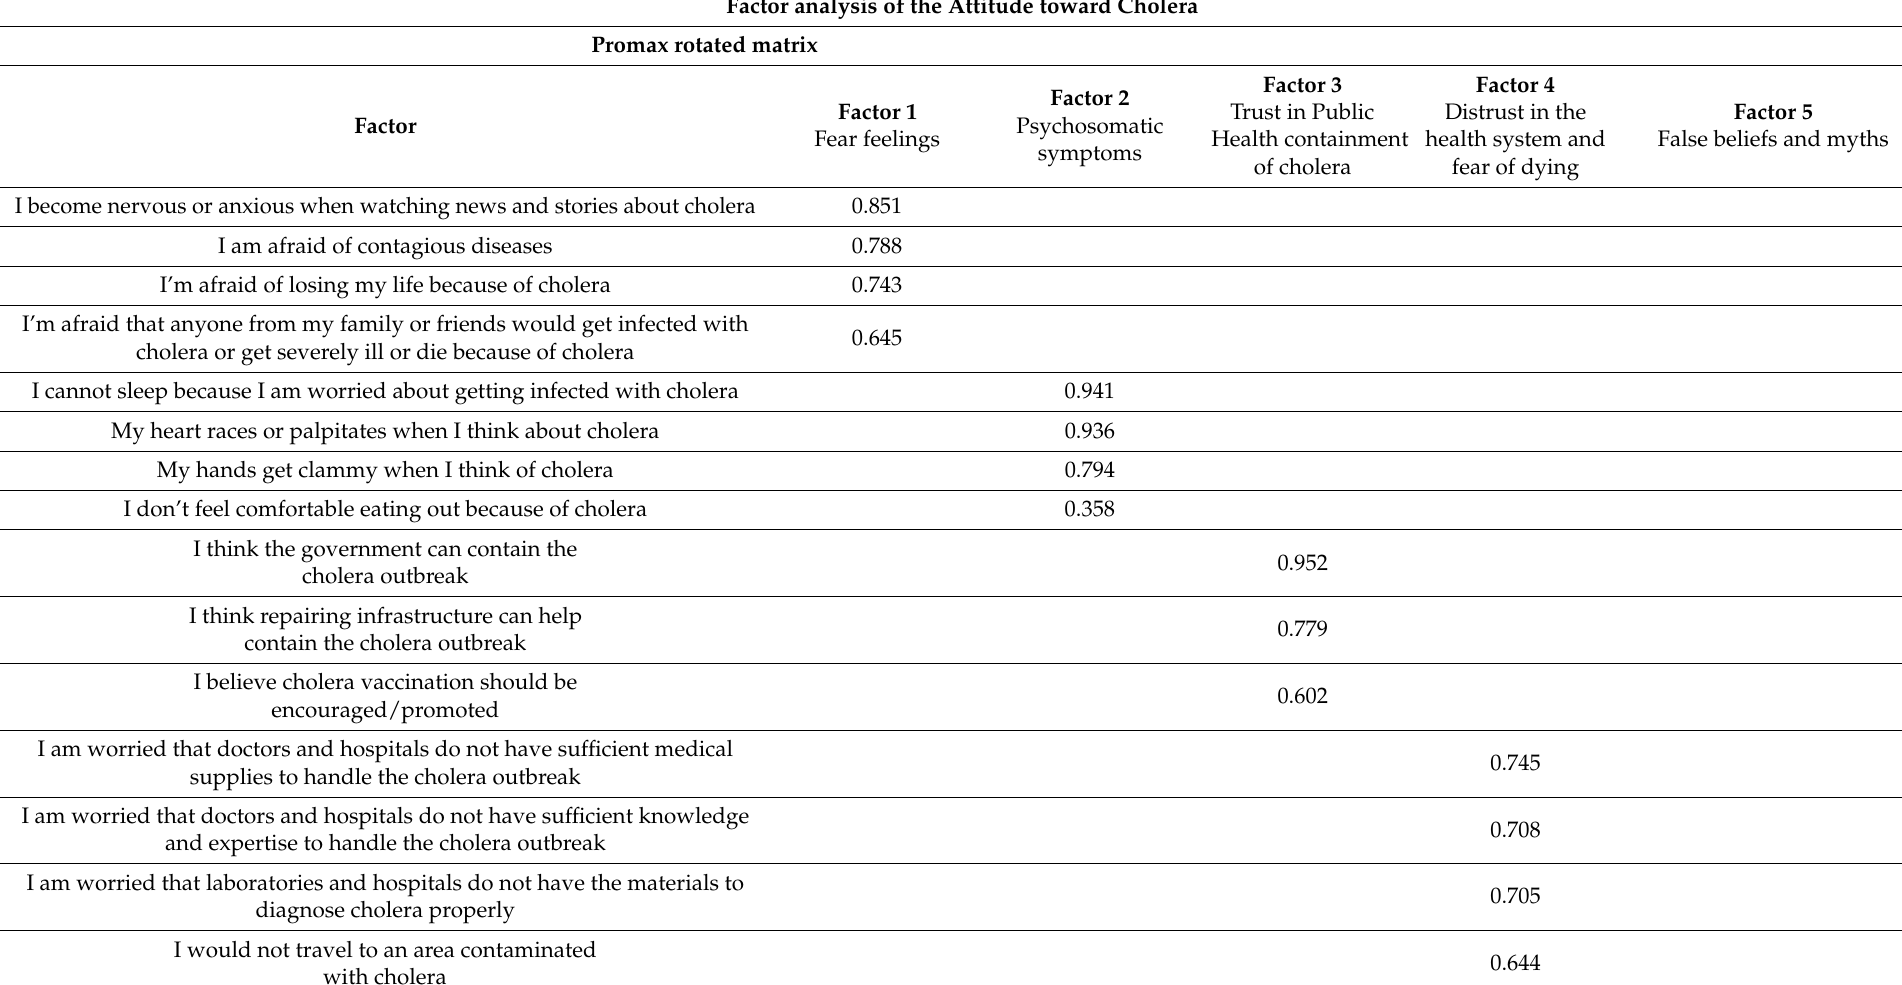
Factor analysis of the Attitude toward